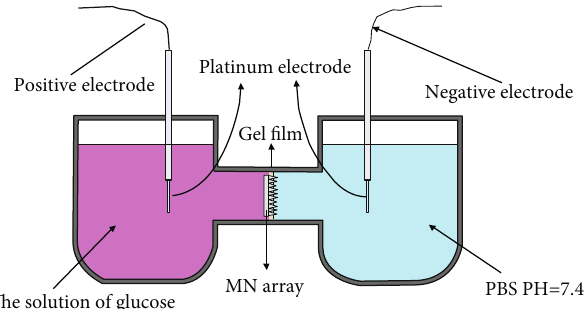
Figure 3: Schematic of iontophoresis drug research in di ff usion cell.